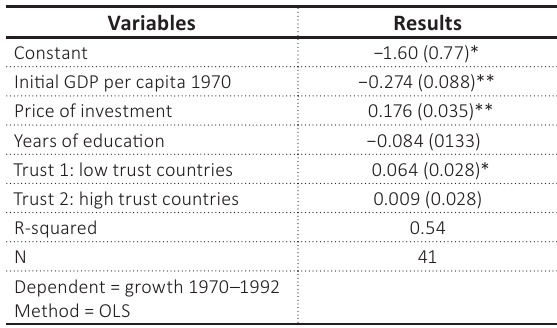
Table 2. Sub-sample estimation of trust